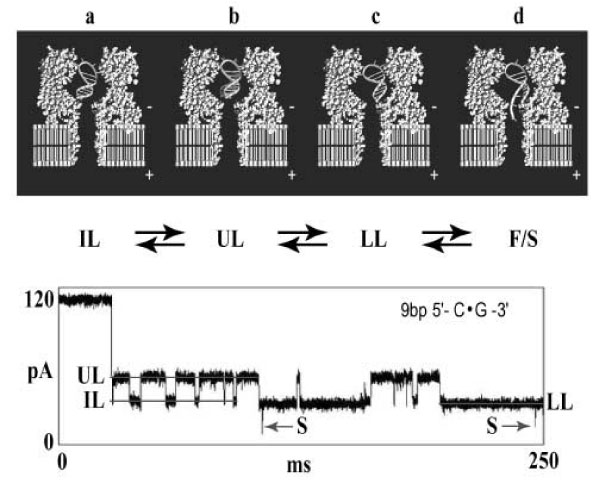
Shows the nine base pair DNA hairpin blockade mechanism (from [11]). When a 9 bp DNA hairpin initially enters the pore, the loop is perched in the vestibule mouth and the stem terminus binds to amino acid residues near the limiting aperture. This results in the IL conductance level. When the terminal base pair desorbs from the pore wall, the stem and loop may realign, resulting in a substantial current increase to UL. Interconversion between the IL and UL states may occur numerous times, or UL may convert to the LL state. The LL state corresponds to binding of the stem terminus to amino acids near the limiting aperture but in a different manner from IL. From the LL bound state, the duplex terminus may fray with rapid extension and capture of one strand in the pore constriction (denoted F/S).